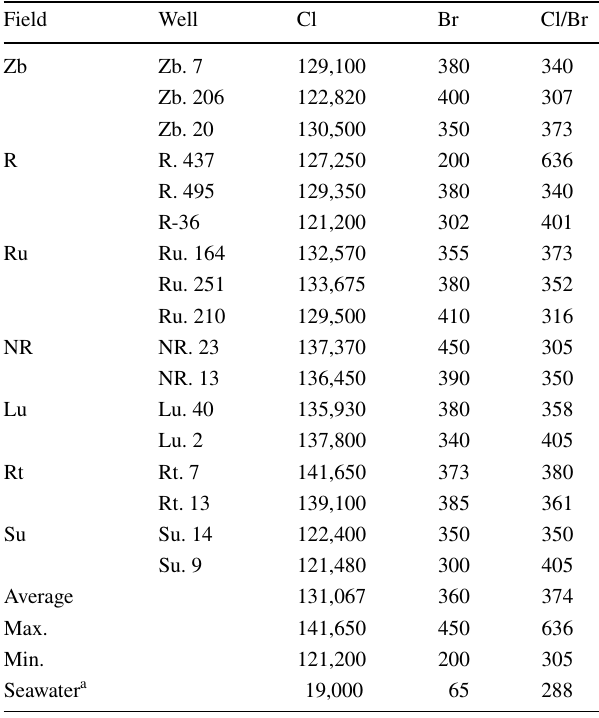
Table 5 Cl and Br concentration (ppm) and Cl/Br in the Zubair brines compared to the